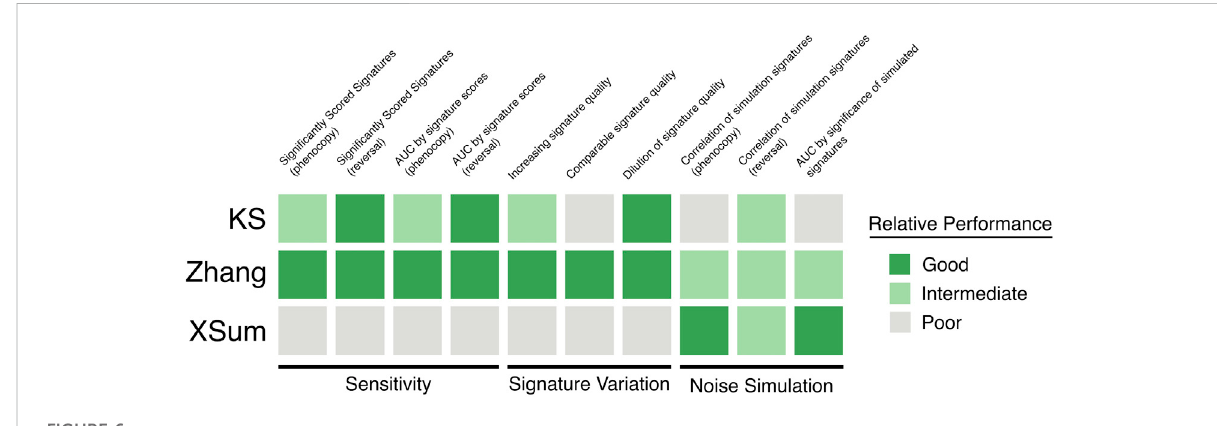
FIGURE 6 Summary of the relative performance of the three in silico drug repurposing algorithms. Bright green: good, dull green: intermediate, grey: